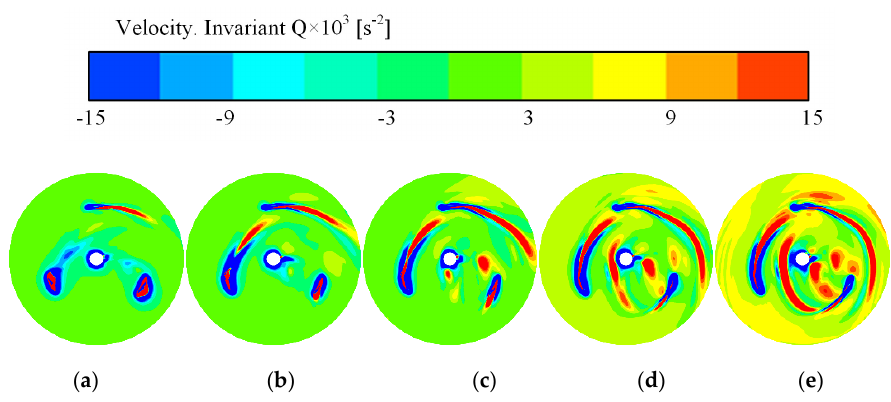
Figure 10. Tip vortex distribution at 101% blade height plane in different λ . ( a ) λ = 1.0; ( b ) λ = 1.5; ( c ) λ = 2.0; ( d ) λ = 2.5; ( e ) λ = 3.0.